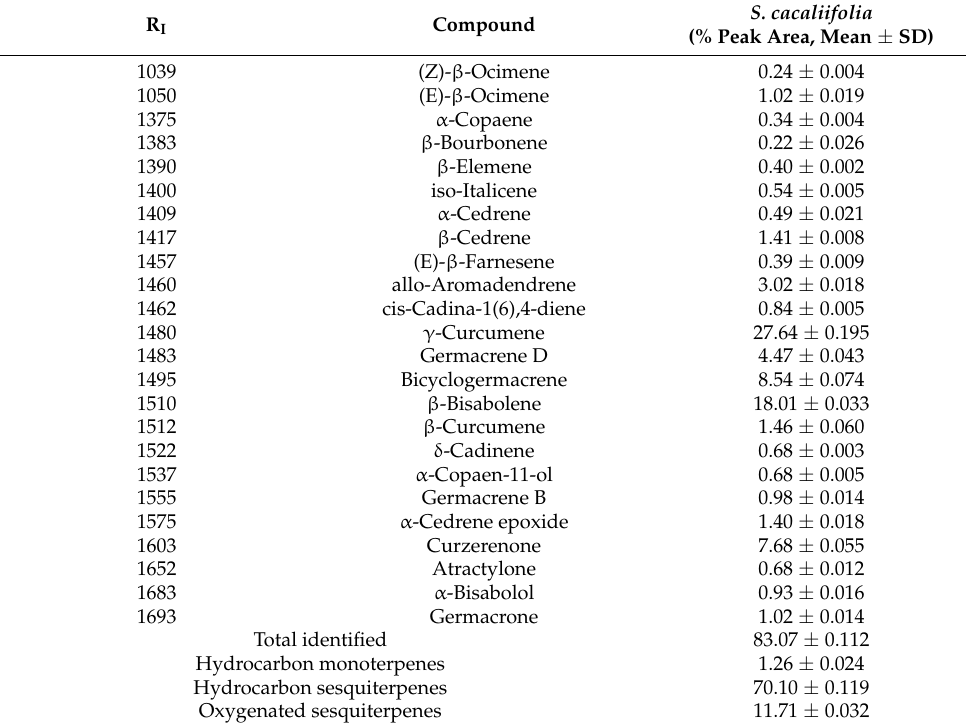
Table 1. Chemical composition of S. cacaliifolia essential